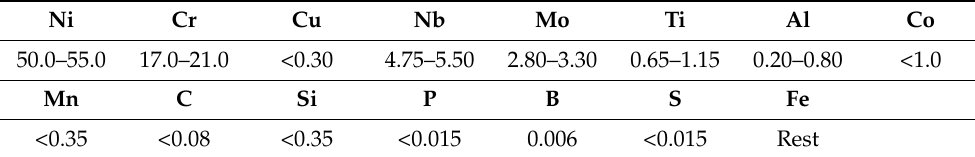
Table 1. Chemical composition of Inconel 718 superalloy